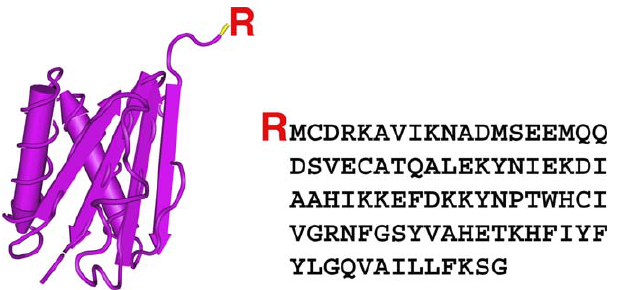
Figure 5. 8-kDa Dynein Light Chain Is Arginylated on N-Terminal Met That Is Exposed on the Molecule Surface Crystal structure (left) and primary amino acid sequence (right) of 8-kDa dynein light chain with the arginylated position marked in yellow on the polypeptide chain and denoted with red letter R. Arginylation results in modification of the protein surface, expected to affect molecular interactions and possibly association with the dynein polypeptide complex.